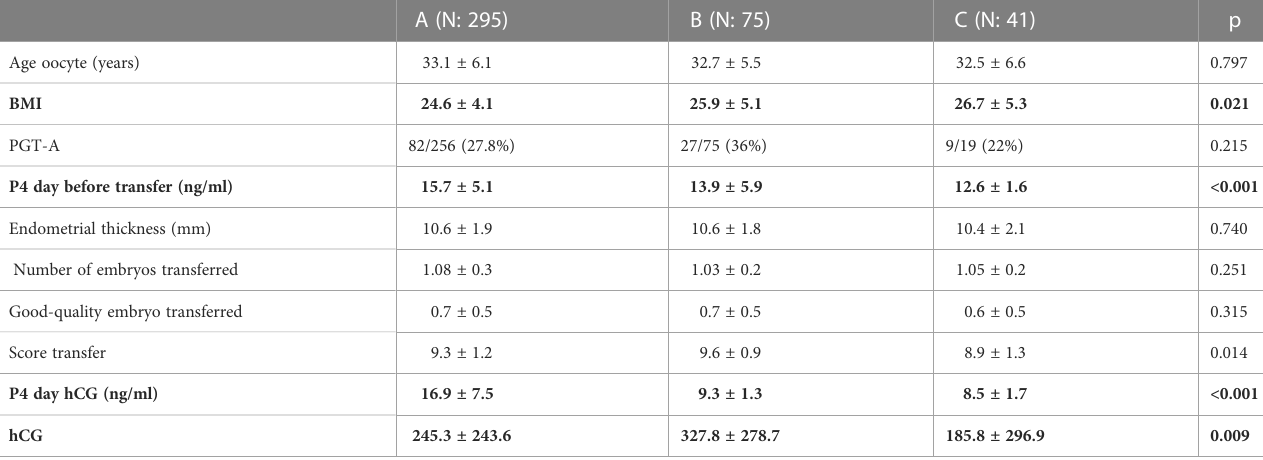
TABLE 3 Only hCG- positive cycles (hCG ≥ 10 IU); group division is based on the levels of P4 on the day of pregnancy test and supplementation or no supplementation.